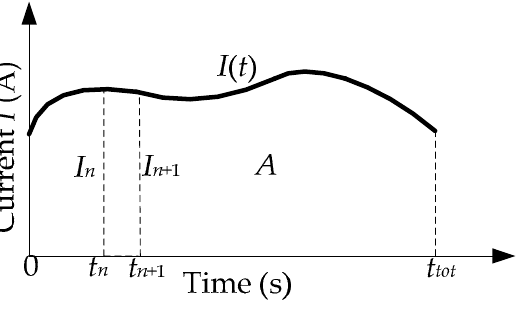
Figure 41. Calculation of the de fi nite integral.